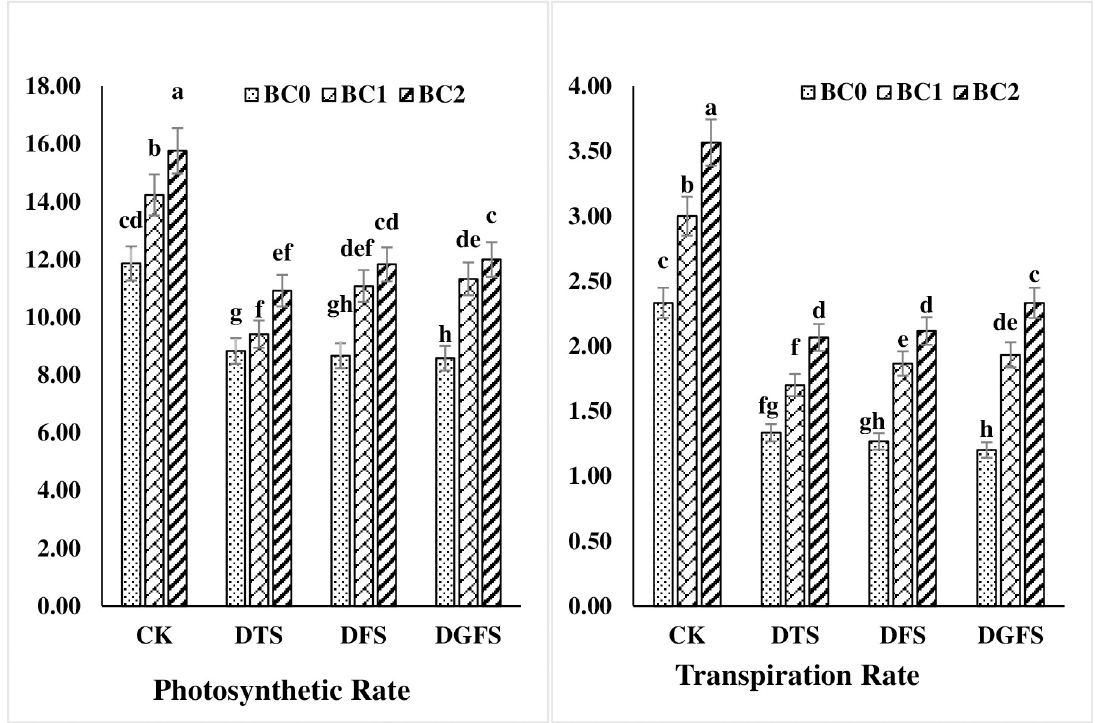
Fig 3. Photosynthetic rate ( μ mol CO 2 m -2 S -1 ) and transpiration rate (mmol H 2 O m -2 S -1 ) affected by biochar application under drought stress at critical growth stages of wheat. CK, DTS, DFS and DGFS indicates control, drought at tillering, flowering and grain filling stages respectively. BC 0 , BC 1 and BC 2 indicates control, 3% and 5% biochar respectively. Error bars indicates standard error (n =